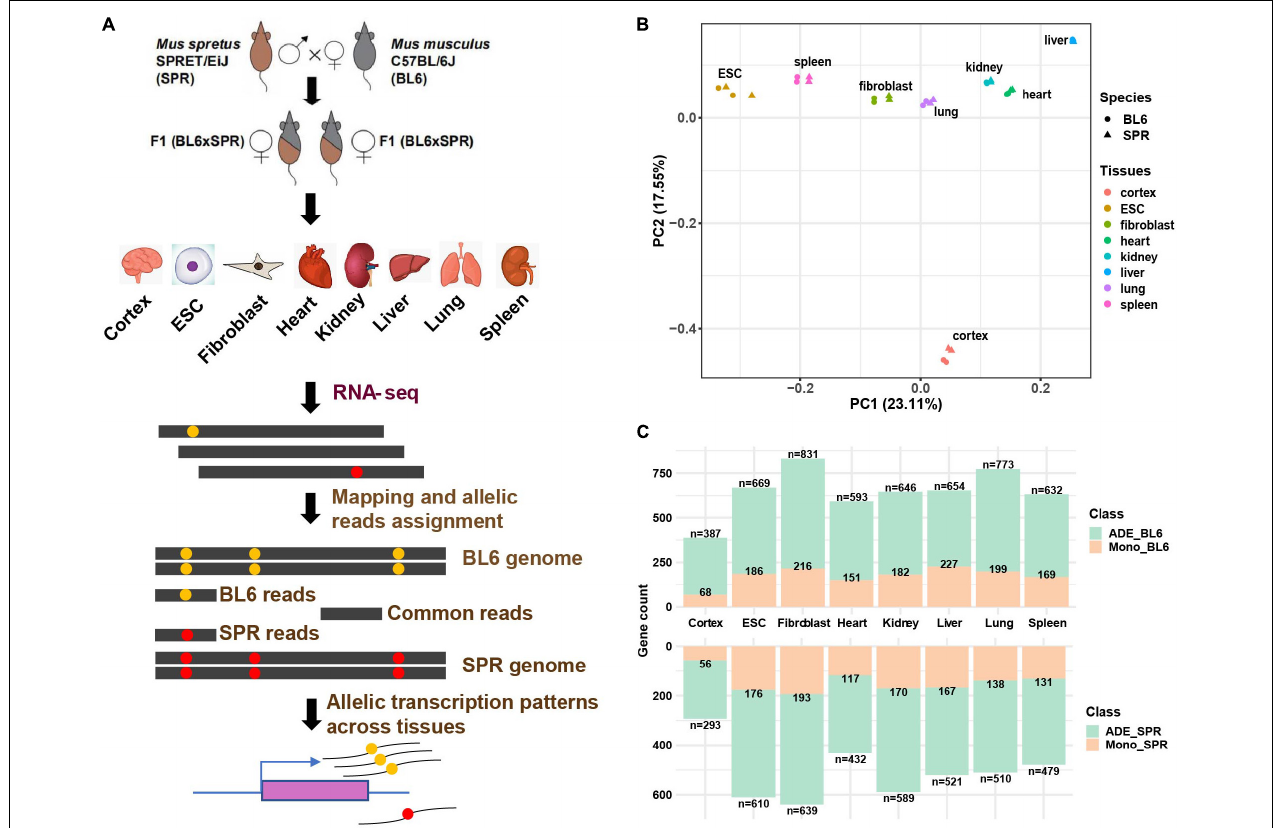
FIGURE 1 | Allelic gene expression profiling across eight tissues/cell types in F1 hybrid mice. (A) Scheme of the experimental design and pipeline for allelic gene expression analysis. (B) View of the first two principal components of allelic samples. PCA analysis was performed with all expressed genes. Species are indicated with shapes and tissue types are distinguished by colors. (C) Allelic differentially expressed (ADE) genes and monoallelic genes in each tissue. The numbers of ADEs and monoallelic genes are indicated in the overhang and within each bar,